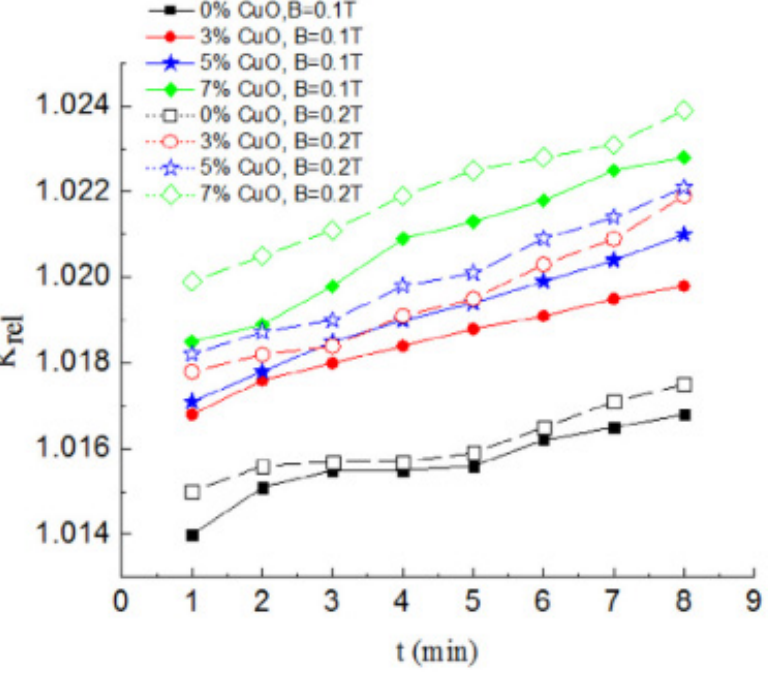
Figure 9. Effect of increasing magnetic field intensity and CuO + 3 wt% Fe 3 O 4 nanofluids on relative thermal conductivity under increasing exposure duration [129].